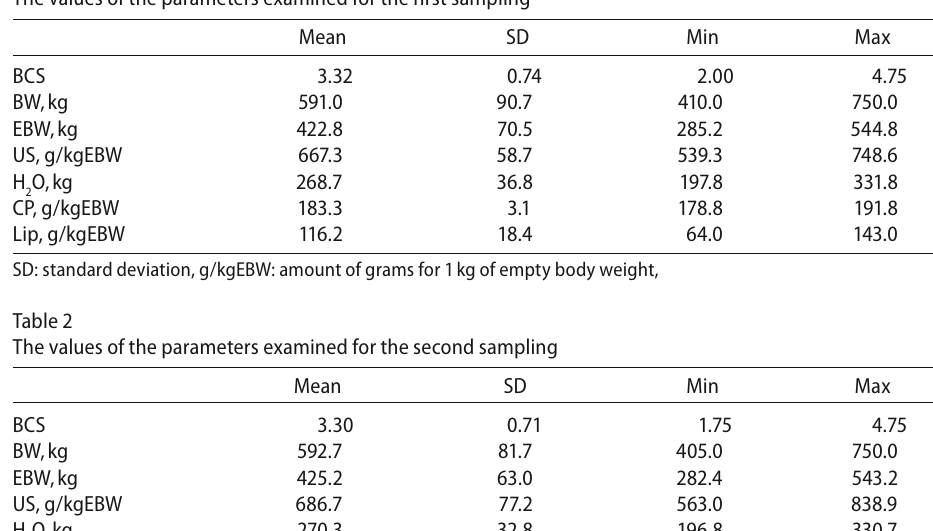
The values of the parameters examined for the first sampling Mean SD Min Max BCS 3.32 0.74 2.00 4.75 BW, kg 591.0 90.7 410.0 750.0 EBW, kg 422.8 70.5 285.2 544.8 US, g/kgEBW 667.3 58.7